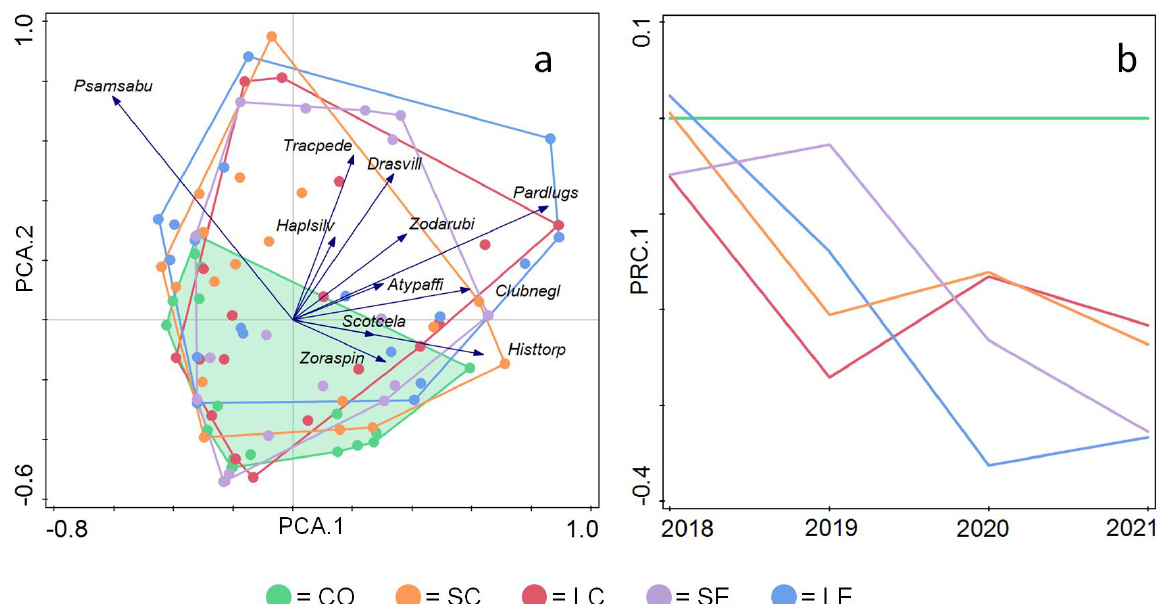
Figure 4. Ordination plots of spider community change in gap treatments and over time. ( a ) PCA biplot. Dots indicate the position of spider assemblages in yearly samples of experimental plots in the different treatments, only considering post-implementation years; species arrows indicate species responses in the ordination space. ( b ) Principal Response Curves analysis plot indicates along one ordination axis how much assemblages in the different treatments differ from control assemblages over the investigated period. Abbreviation of treatments as in legend to Figure 1; species abbreviations as follows: Psamsabu = Psammitis sabulosus , Tracpede = Trachyzelotes pedestris , Haplsilv = Haplodrassus silvestris , Drasvill = Drassyllus villicus ; Atypaffi = Atypus affinis ; Scotcela = Scotina celans , Zoraspin = Zora spinimana , Pardlugs = Pardosa lugubris , Clubnegl = Clubiona neglecta , Histtorp = Histopona torpida .